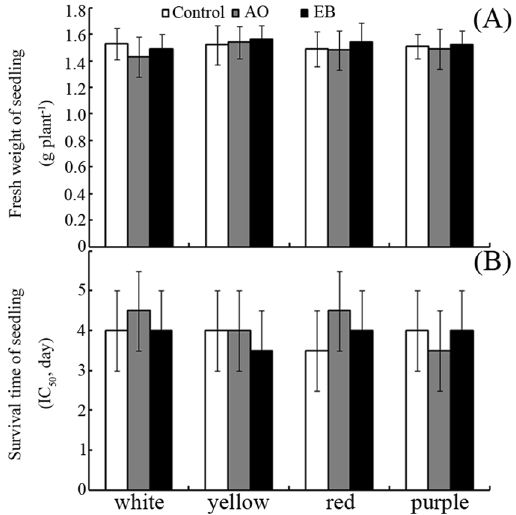
Figure 7. Seedling growth and drought tolerance. ( A ) Fresh weights and ( B ) drought tolerance (evaluated with IC 50 ) of maize seedlings grown from mutagen-treated seeds. Bars represent standard deviations of means ( n = 5); means followed by the same letter are not significantly different ( p < 0.05) among treatments. AO, acridine orange; EB, ethidium